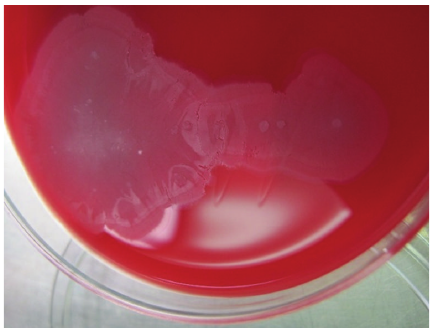
Figure 1: K. gyiorum appear as gray colonies with spreading edges on blood agar.